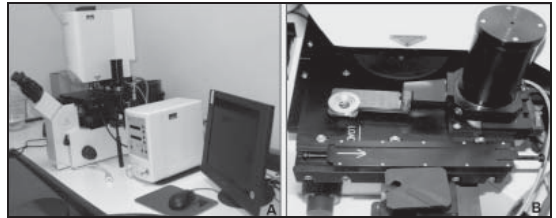
Figura 1 – A: Sistema de microdissecção e captura a laser (MCL), monitor de vídeo, fonte do laser e microscópio mostrando o joystick e o botão que aciona o tiro do laser. B: Suporte para os caps e o braço transportador do cap até a